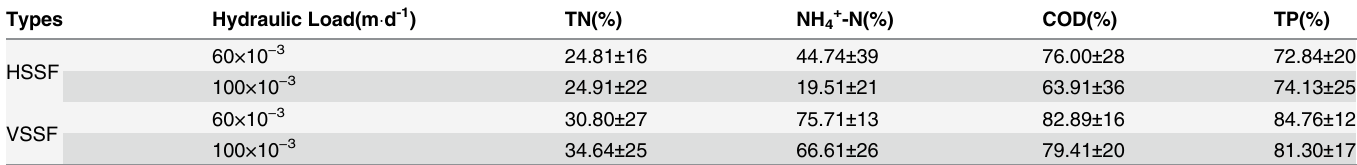
Table 2. Removal rate of main pollutants in constructed wetlands. Types